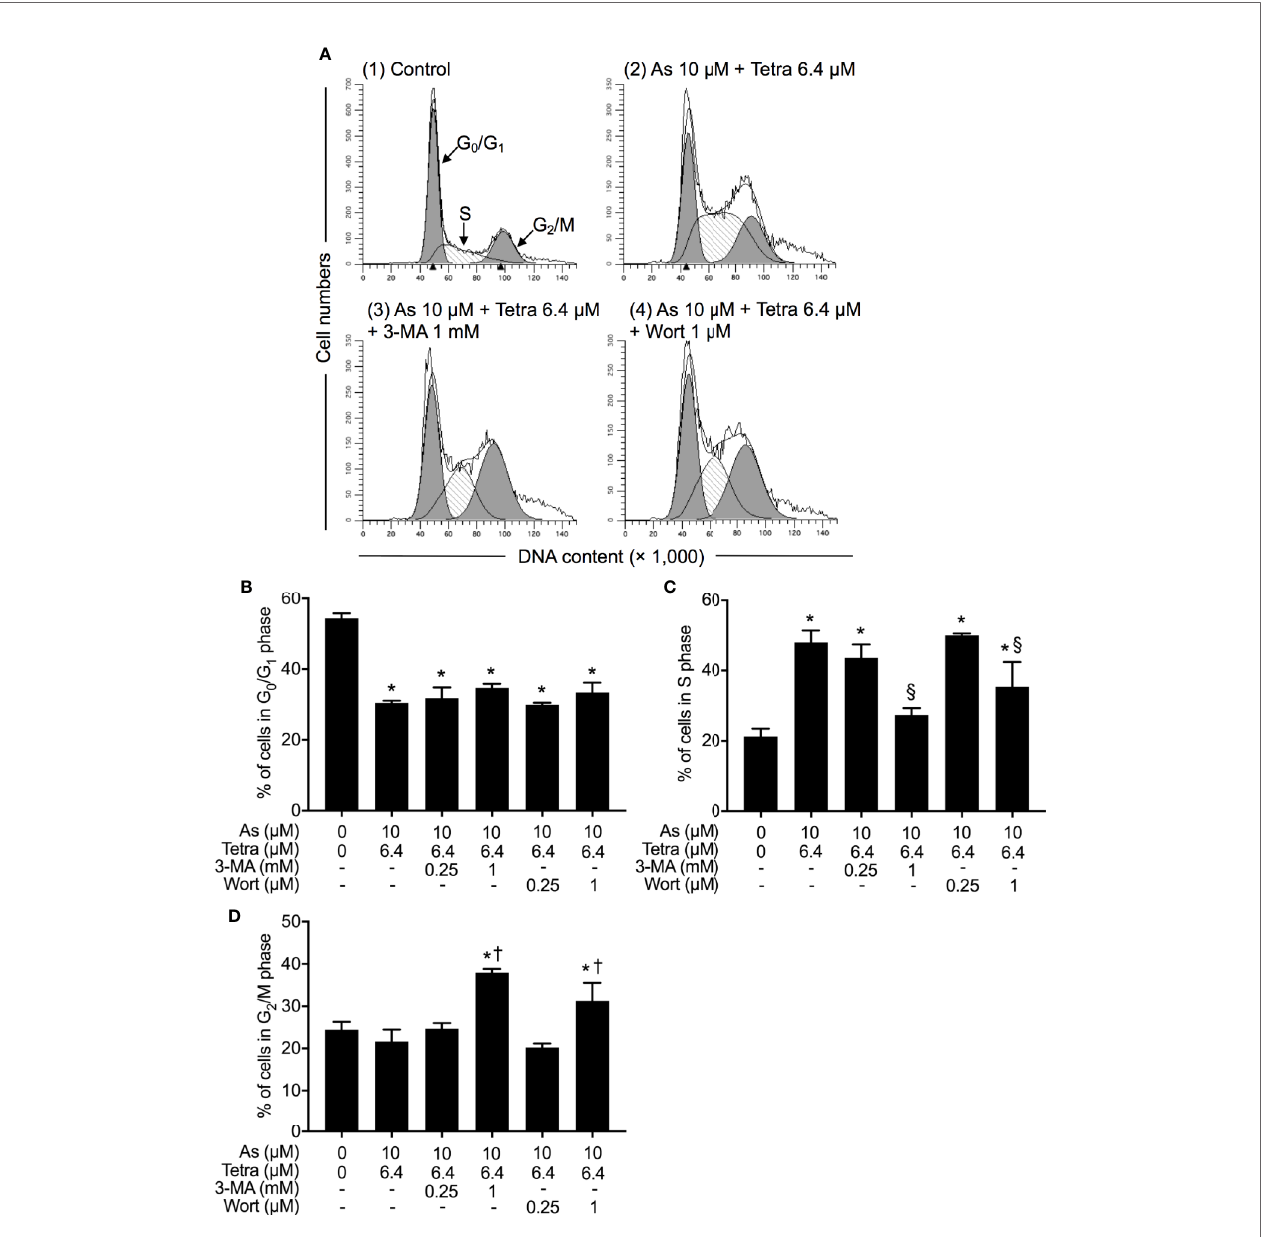
FIGURE 5 | Contribution of autophagy to the cytotoxicity of As III combined with Tetra in MDA-MB-231 cells by modulating cell cycle progression. (A – D) After treatment with 10 m M As III +6.4 m M Tetra in the presence or absence of 3-MA (0.25, 1.0 mM) or wortmannin (0.25, 1.0 m M) for 48 h, cell cycle pro fi ling was performed by FACSCanto fl ow cytometer. Analyzed data and pro fi les for each G 0 /G 1 and G 2 /M phase using Diva software and ModFit LT ™ ver.3.0. are shown in the gray area. Cells at S phase are shown as shaded area. A representative FACS histogram from three separate experiments is shown (A) . *p<0.05, vs. control; § p<0.05, † p<0.01, vs. 10 m M As III +Tetra 6.4 m M. As, As III ; Tetra, tetrandrine; Wort,